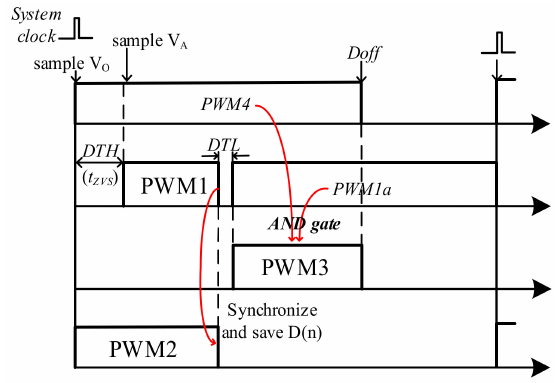
Figure 7. The waveform and generation of PWM